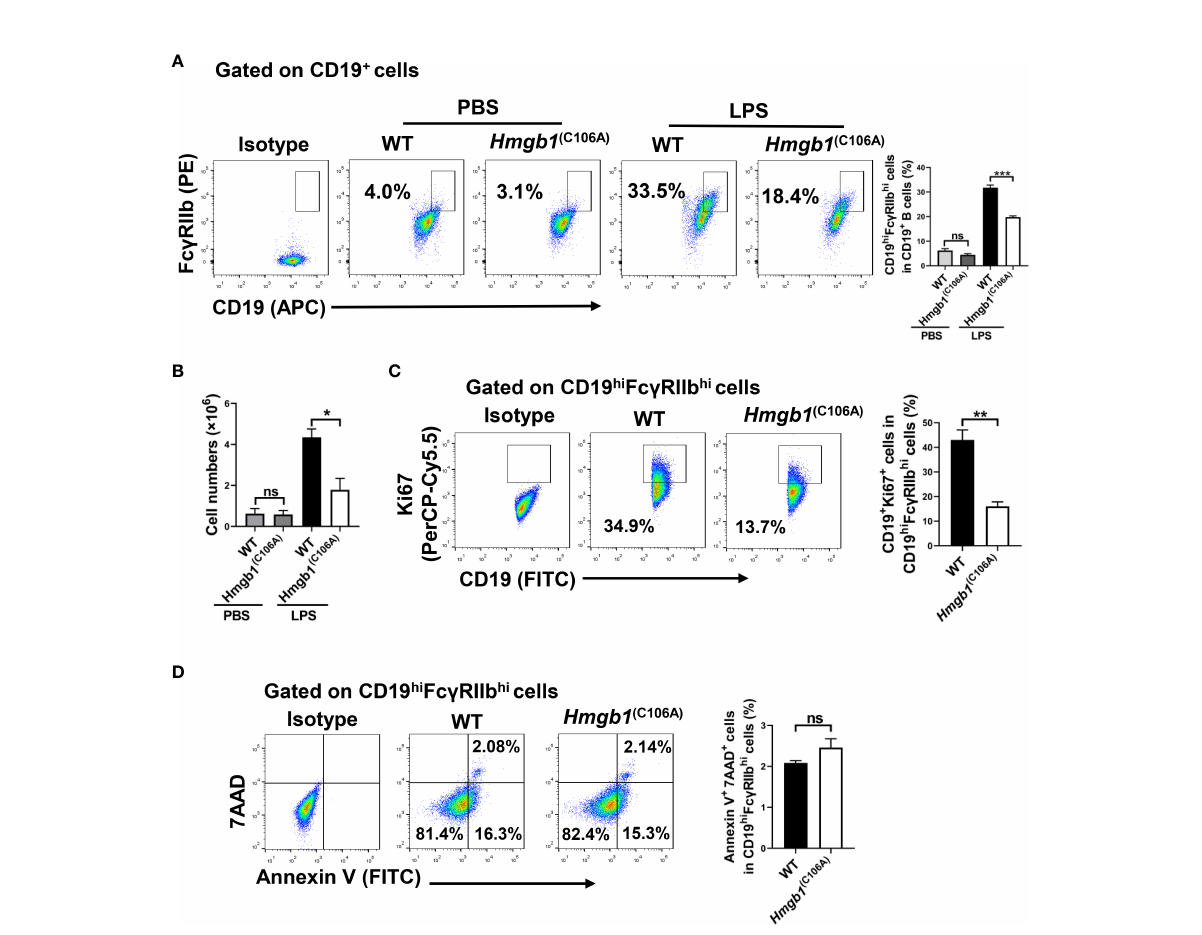
FIGURE 1 Decreased CD19 hi Fc g RIIb hi B cell percentage and number in Hmgb1 (C106A) mice. PBS or LPS was injected into WT and Hmgb1 (C106A) mice, and the mice were euthanized 7 days later. (A) Percentage and (B) number of CD19 hi Fc g RIIb hi B cells in the spleen, analyzed by fl ow cytometry. Data are shown as means ± SEMs of three independent experiments. (C) Percentage of proliferating (Ki67 + ) CD19 hi Fc g RIIb hi B cells in WT and Hmgb1 (C106A) mouse spleens, analyzed by fl ow cytometry with Ki67 staining. Data are shown as means ± SEMs of three independent experiments. (D) Representative staining and percentage of AnnexinV + 7AAD + cells among CD19 hi Fc g RIIb hi B cells from WT and Hmgb1 (C106A) mouse spleens, analyzed by fl ow cytometry. Data are shown as means ± SEMs of three independent experiments. NS, not signi fi cant; *P <